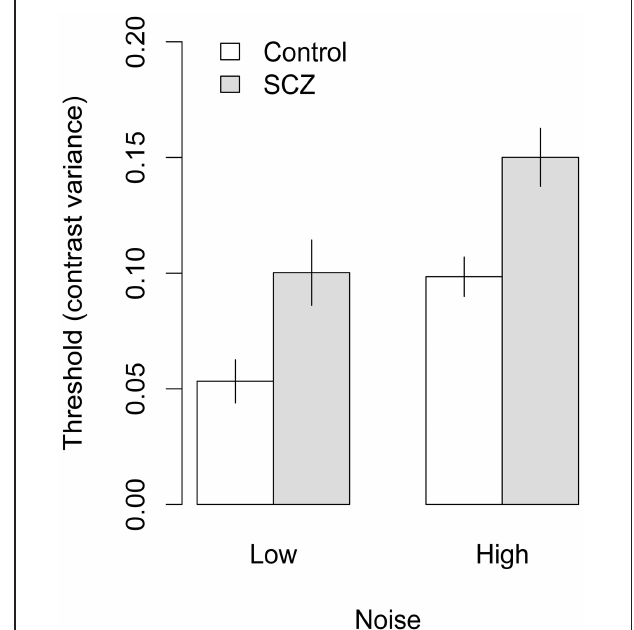
FIGURE 4 | Face identification thresholds measured with upright faces and expressed in terms of contrast variance. In both high and low noise conditions, people with SCZ demonstrate higher thresholds, and thus, decreased performance for face identification. Error bars represent ± 1 standard